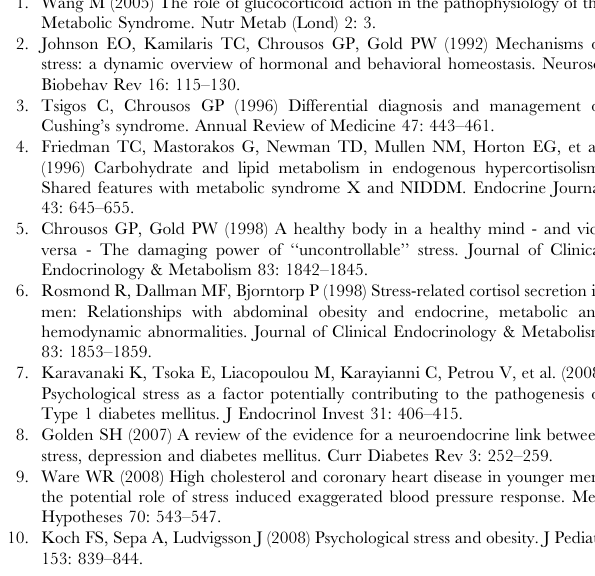
Table S1 List of 5 9 to 3 9 oligonucleotide sequences used as forward and reverse primers.